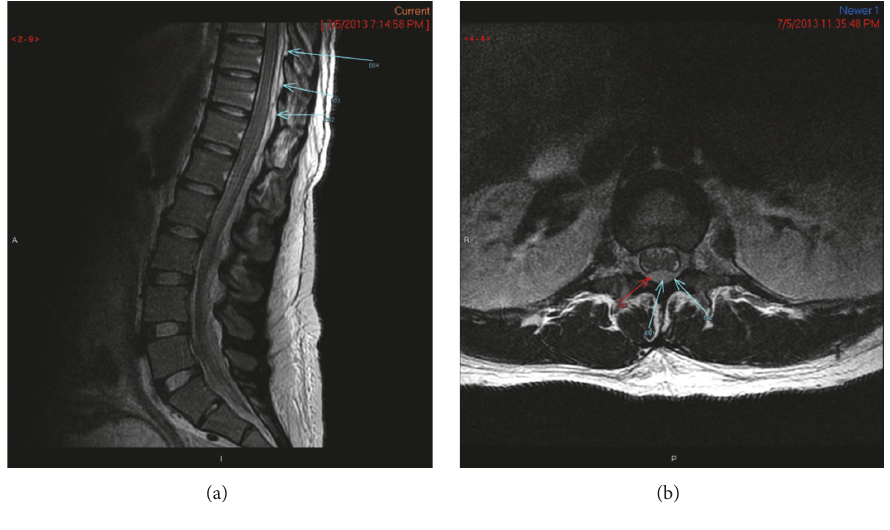
Figure 1: Images of SEA